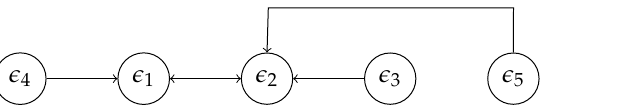
Figure 11. Causality diagram for simulated data—Gaussian noise and Cauchy disturbance.